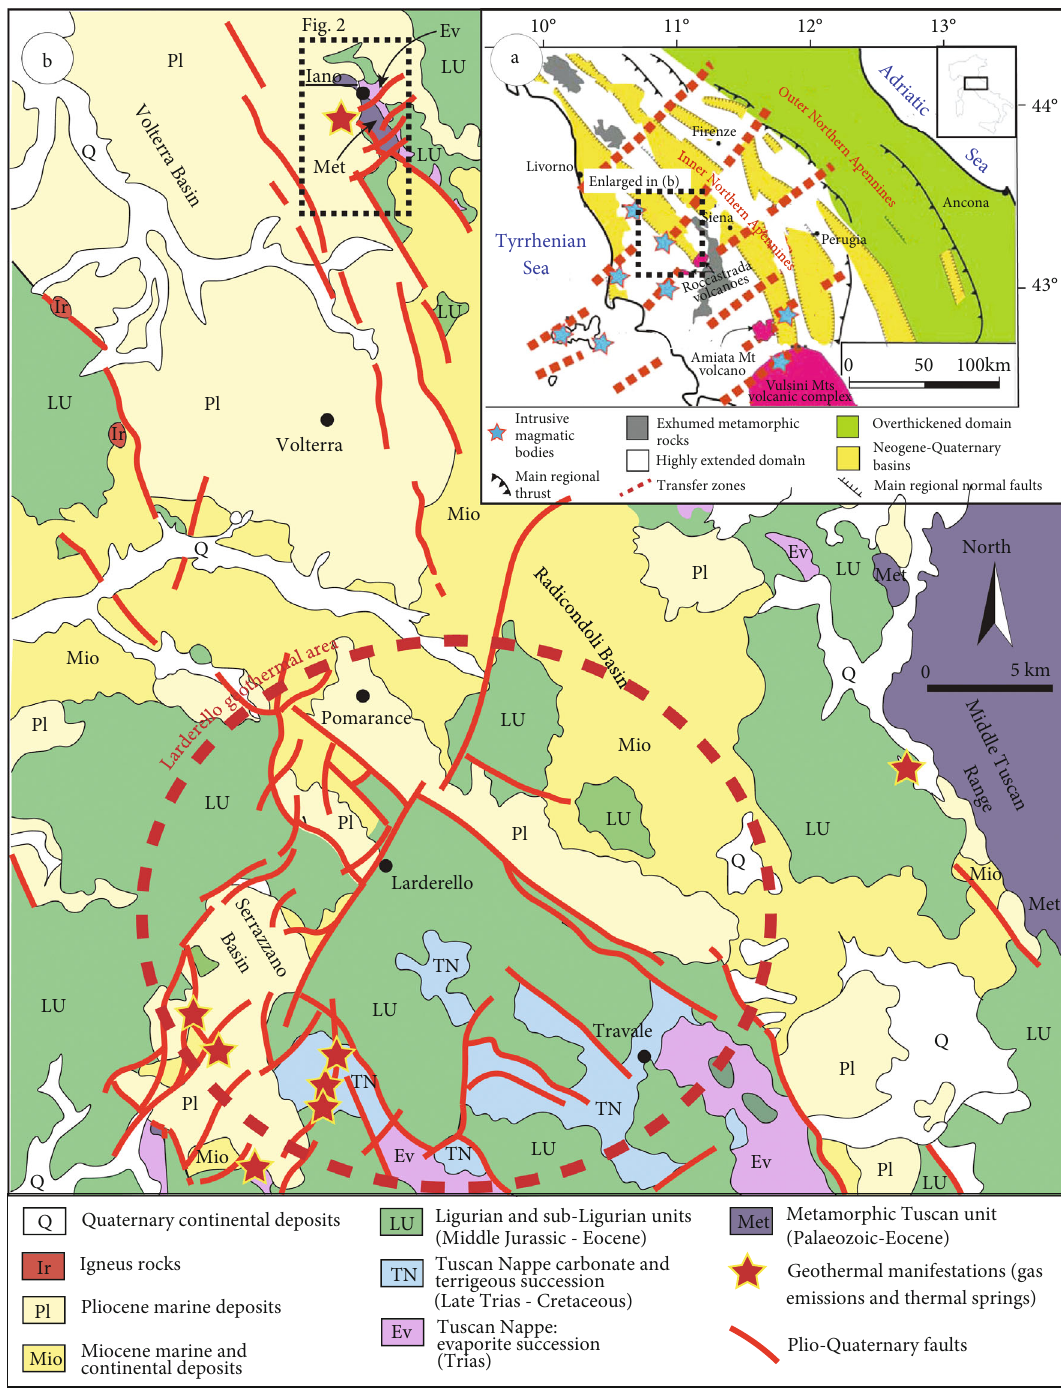
Figure 1: (a) Structural map of the Northern Apennines highlighting the main transfer zones from [19] and (b) geological map of the Larderello geothermal area and Volterra Basin. The study area is also indicated. Redrawn after Brogi et al.[134] and Liotta and Brogi